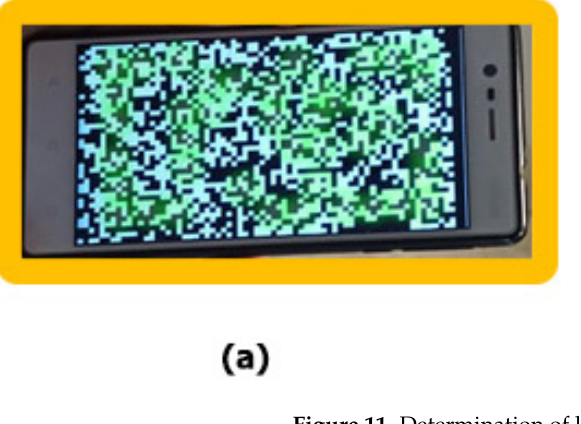
Figure 11. Determination of key points by detection frames; ( a ) reception area, ( b ) image in original format.